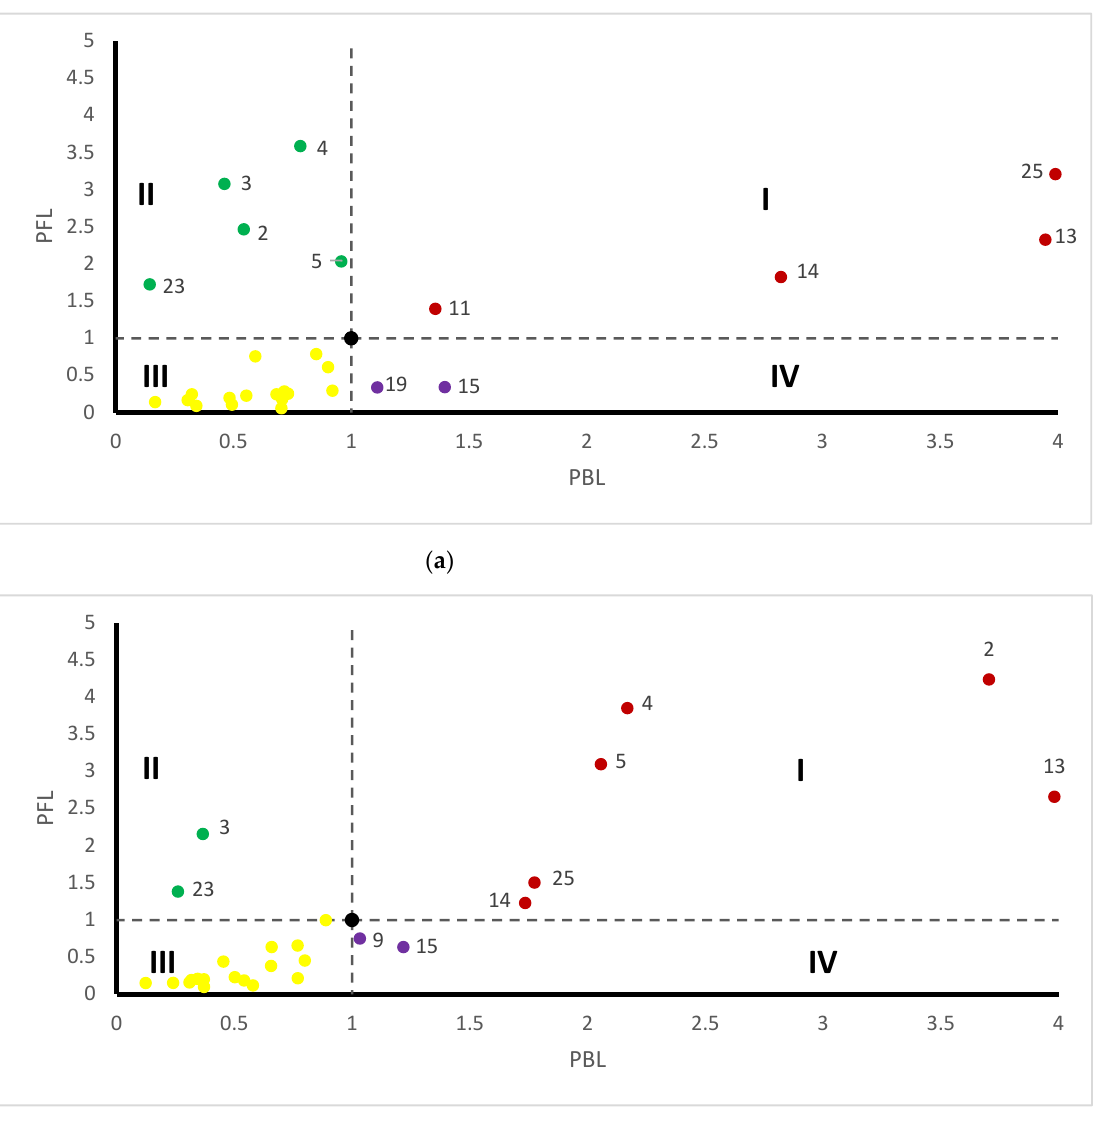
Figure 4. Flow structure of embodied pollutants between industrial sectors. ( a ) NO x ; ( b ) PM.